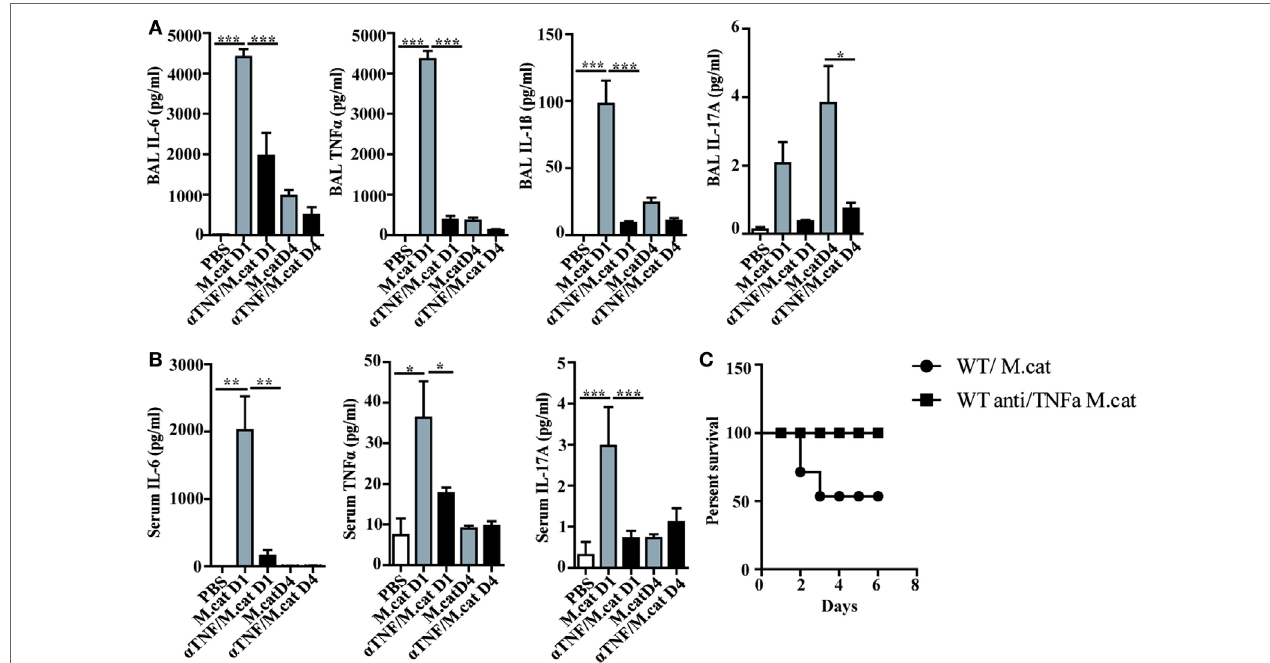
FigUre 3 | Neutralization of TNF- α protects against respiratory M. catarrhalis infection. C57BL/6 animals received a single i.p. injection of 100 µg of anti-TNF- α (black bars) or IgG1 control mAbs (gray bars) and were 4 h later intranasally infected with 2 × 10 8 CFU M. catarrhalis . (a) Amounts of IL-6, TNF- α , IL-1 β , and IL-17 in BALF of untreated or anti-TNF- α -treated mice at indicated time points. (B) As in (a) but in serum (c) Survival of anti-TNF- α -treated animals (circle) or control IgG-treated (square) mice after infection with M. catarrhalis . Data were from two independent experiments, n = 6 mice per group. *** P = 0.001, ** P = 0.01, and * P = 0.05 (one-way ANOVA). BALF, BAL fluid; ANOVA, analysis of